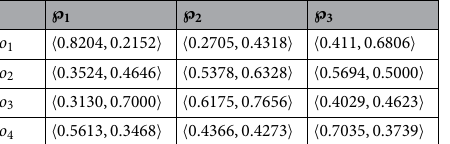
Table 14. Weighted collective q-rung orthopair fuzzy decision matrix.